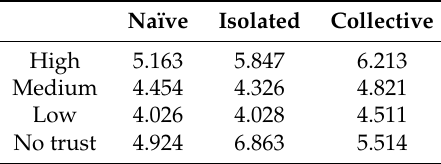
Table 6. Service time with 30%